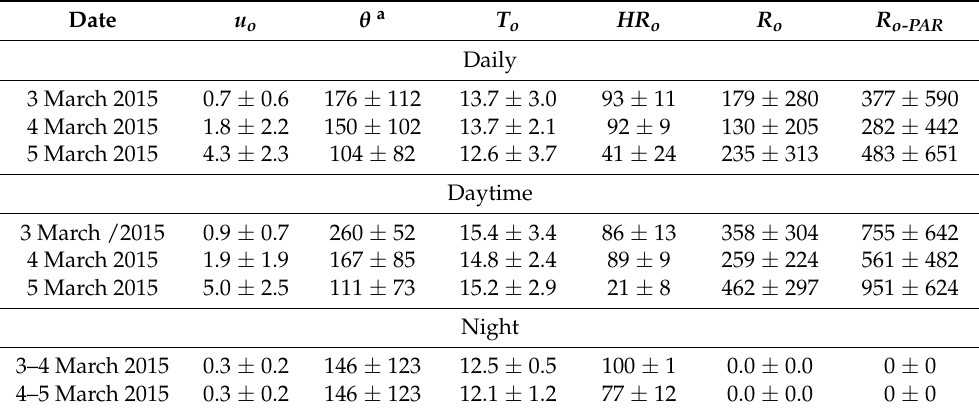
Table 1. Outside climatic conditions (average value ± standard deviation): u o , wind speed (m s − 1 ); θ , wind direction ( ◦ ); HR o , air relative humidity (%); T o , air temperature ( ◦ C); R o , solar radiation